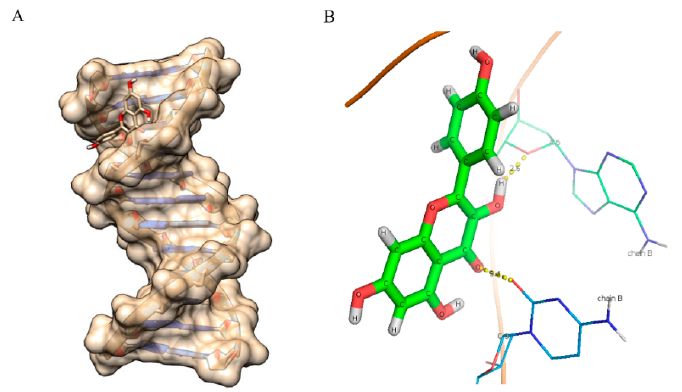
Figure 9 . Molecularly docked structure of kaempferol with B-DNA. ( A ) Surface view interaction of kaempferol with B-DNA; ( B ) Hydrogen bonding interactions (2) and distance in Å of kaempferol with dodecamer duplex of sequence (CGCGAATTCGCG) 2 (PDB ID: 1BNA).